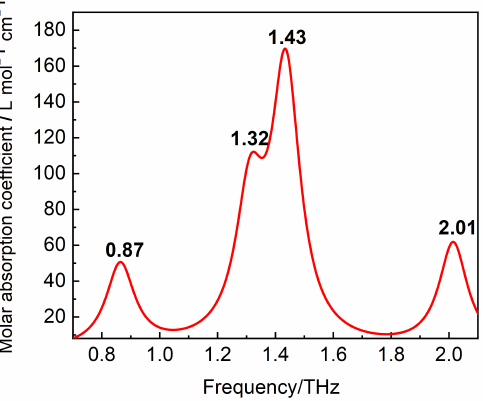
Figure 6. Simulated spectrum of L-arginine suspension in SMD solvent model obtained by B3LYP(D3BJ) and the basis set 6-31G(d), and there are four absorption peaks with the frequencies of 0.87, 1.32, 1.43 and 2.01